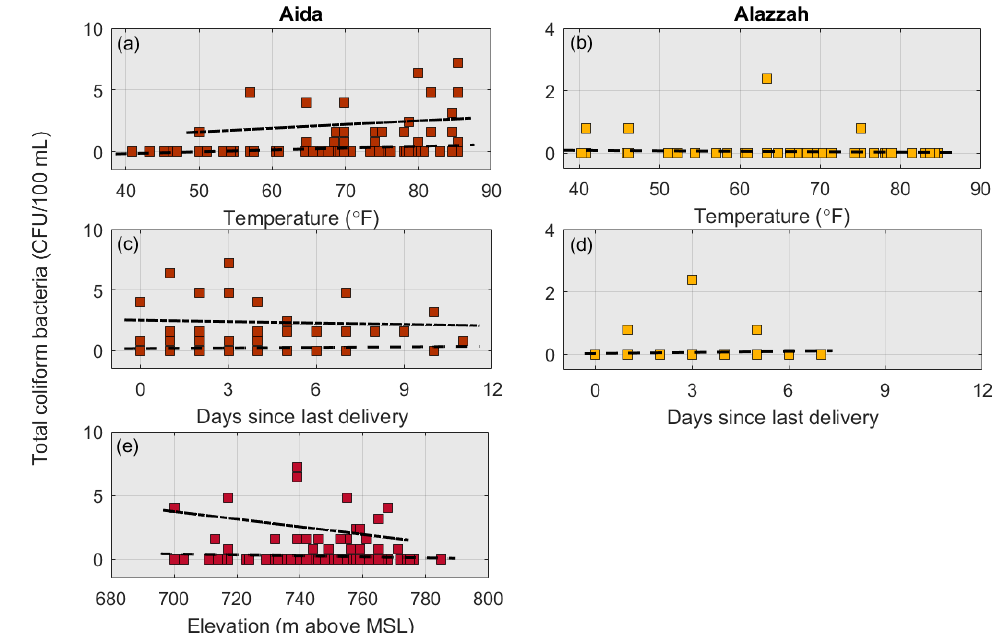
Figure A1. Scatter plots of total coliform bacteria versus ( a ) and ( b ) air temperature, ( c ) and ( d ) days since last water delivery to Aida Camp and Alazzah Camp, and ( e ) house elevation (Aida Camp only) for rooftop-tank samples. Regression lines through all the data are shown with coarsely-dashed lines; regression lines through all the non-zero bacteria data are shown with finely-dashed lines. See Table A1 for summary statistics.